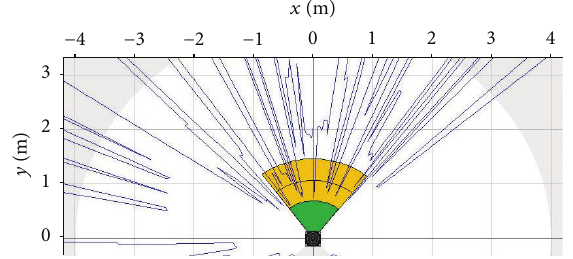
Figure 14: The most proper area for SPWM system detected by sensor.